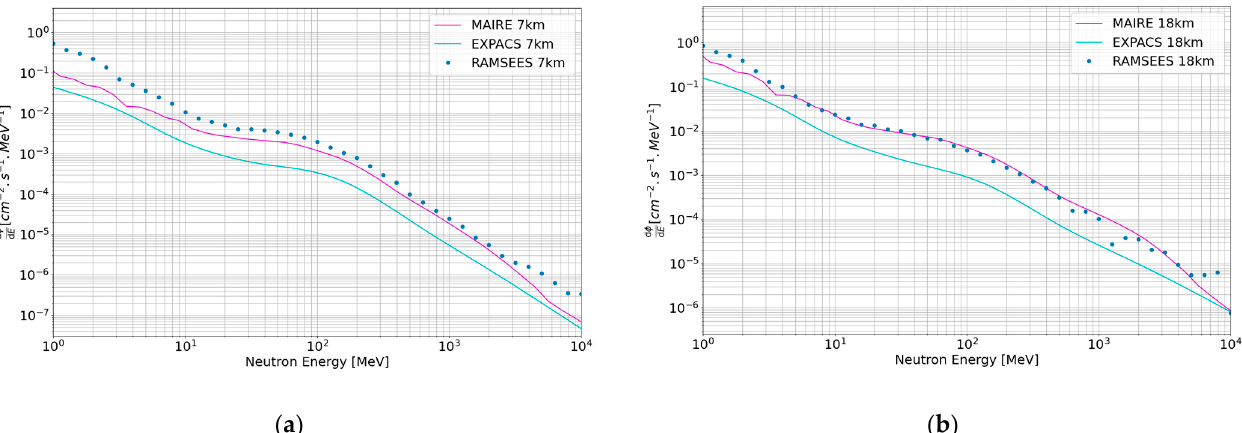
Figure 16. Spectrum of secondary neutrons compared to EXPACS and MAIRE at several altitudes: ( a ) at 7 km and ( b ) at 18 km.